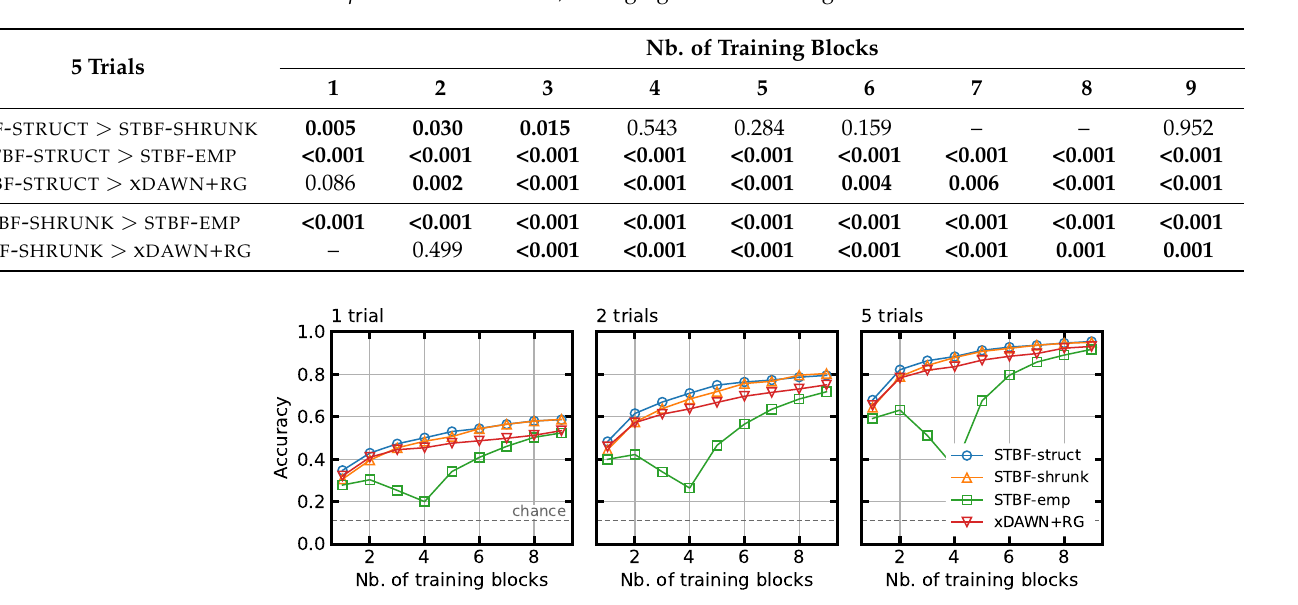
Table 3. p -values as in Table 1, averaging over five testing trials.